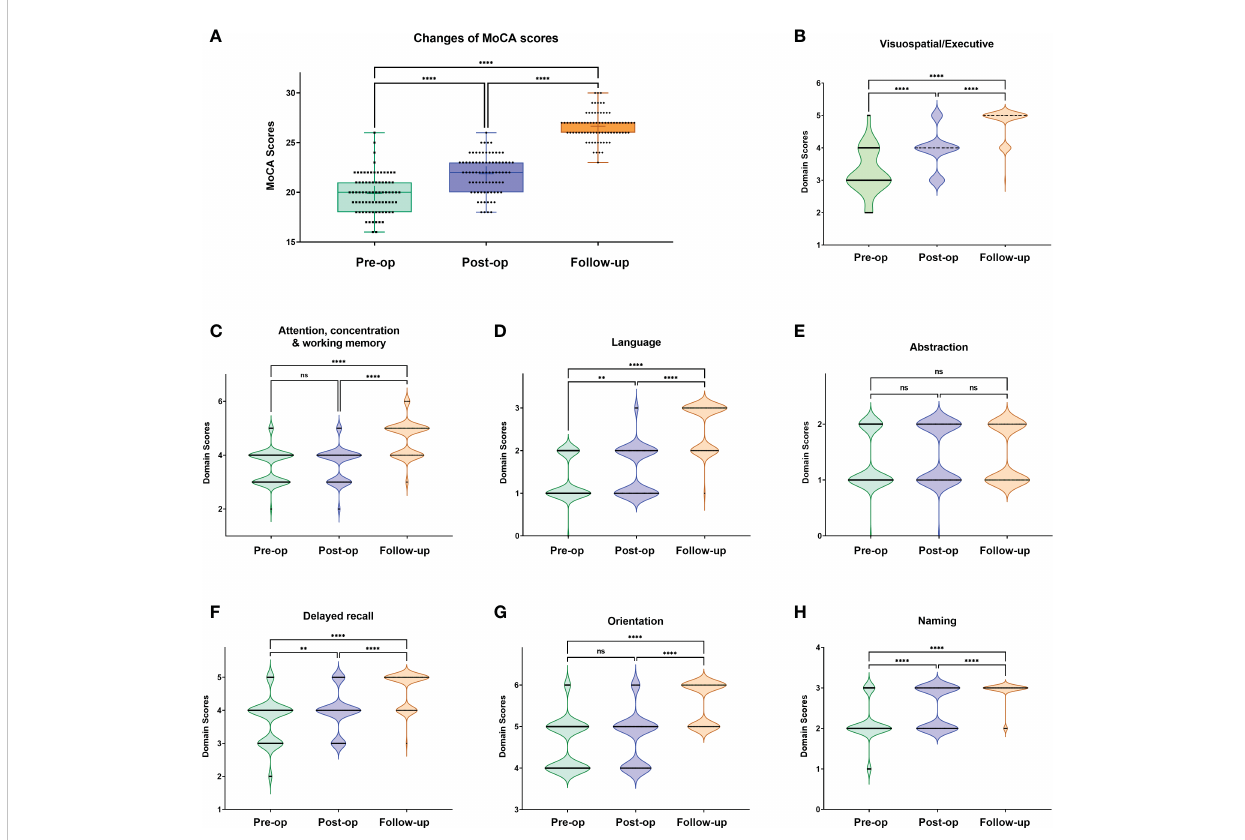
FIGURE 2 Changes of total MoCA scores (A) and subdomain score distribution (B-H) at each MoCA test timepoint. One-way ANOVA with Bonferroni ’ s multiple comparisons tests. **: <0.001; ****:<0.0001; ns, not signi fi